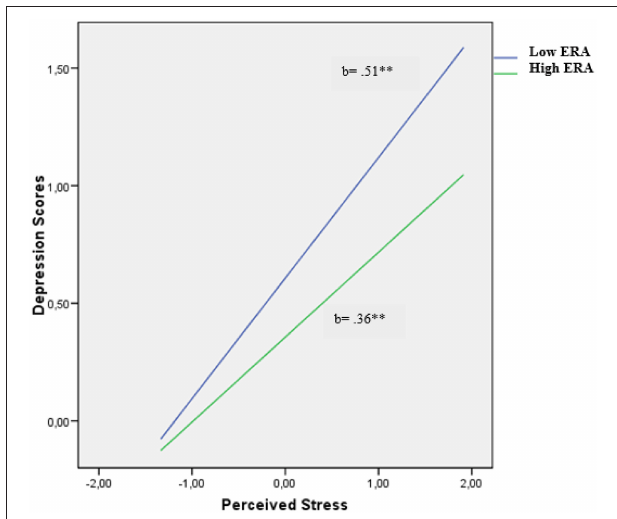
FIGURE 1 | Relationship of perceived stress and emotion regulation ability for predicting depression scores in males. ** p < 0.01 .